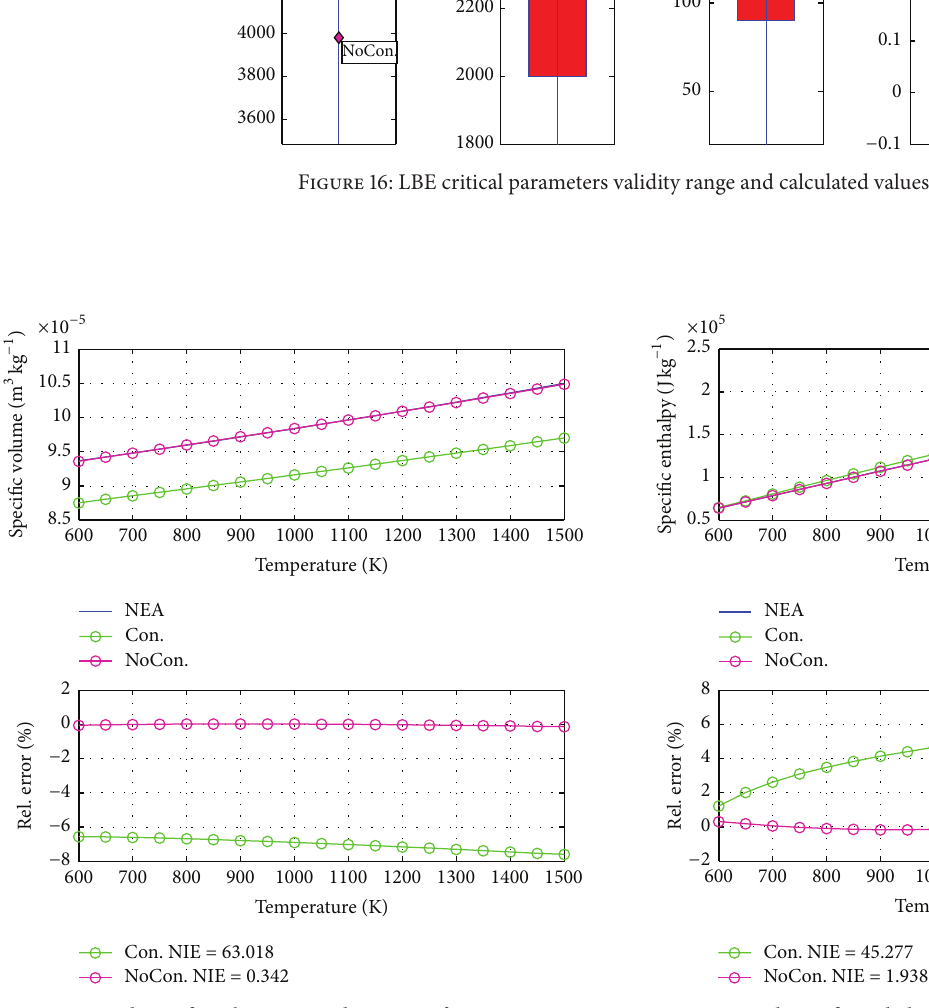
Figure 17: Lead specific volume, NEA data versus free optimization and constrained optimization.